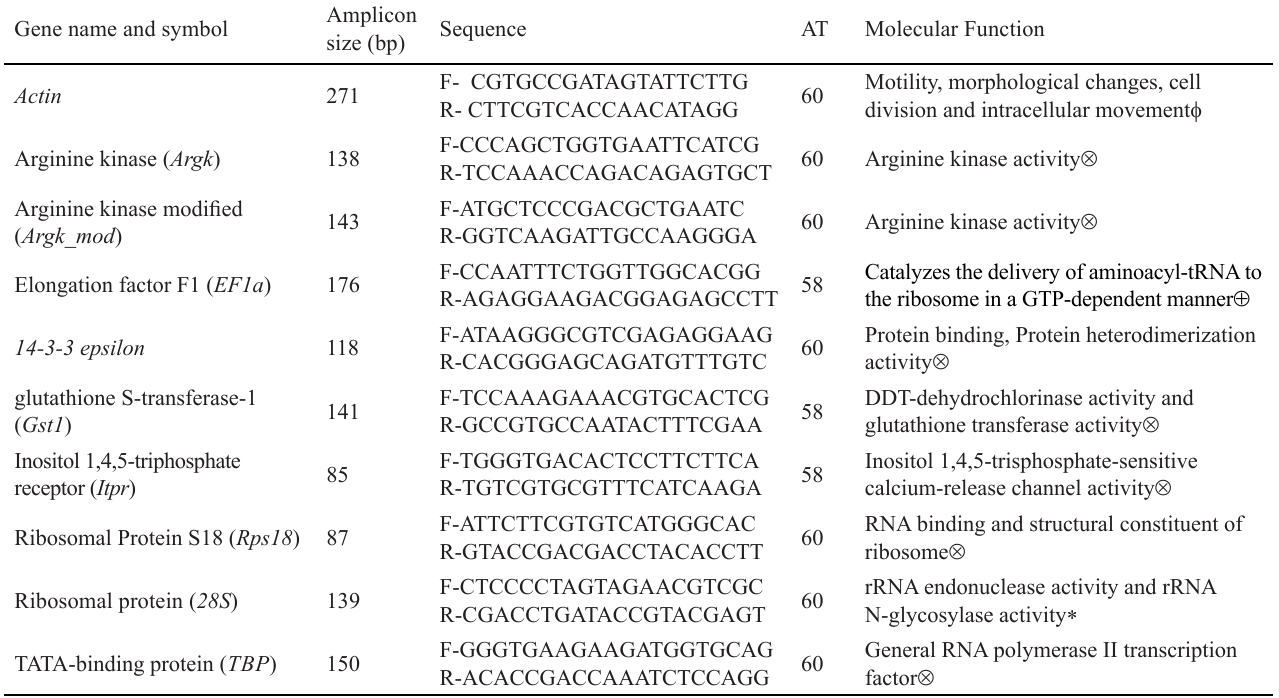
Table 1 . Details of the reference genes designed developed and tested in samples of Euglossa viridissima. Actin , however, was not designed in this study (see Locke et al., 2012 ). bp = base pairs. F = forward primer sequence and R = reverse primer sequence. AT = annealing